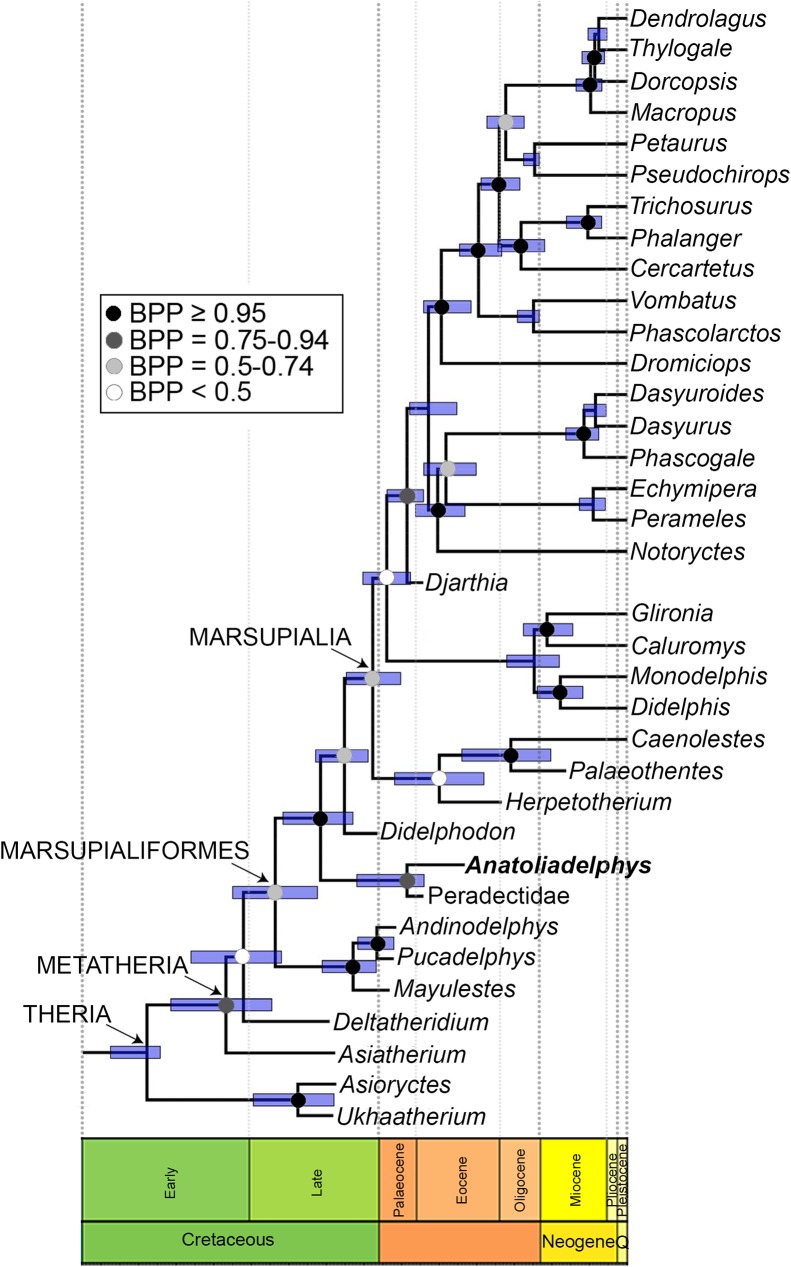
Phylogeny of Metatheria based on Bayesian “tip-and-node dating” analysis of total evidence dataset.The dataset comprises 259 morphological characters and 9012 bp of molecular sequence data from 5 nuclear genes (APOB, BRCA1, IRBP, RAG1 and VWF), assuming a single Independent Gamma Rates (IGR) clock model, “diversity” sampling, and with temporal information provided in the form of tip ages and also constraints (specified as offset exponential distributions) on the ages of selected nodes. The topology represents a maximum clade credibility (MCC) tree. Nodes without Bayesian posterior probabilities were used as age constraints, which required them to be constrained as monophyletic a priori. Blue bars at nodes represent 95% Highest Posterior Densities (HPDs) on node ages. Abbreviations: BPP, Bayesian posterior probability.